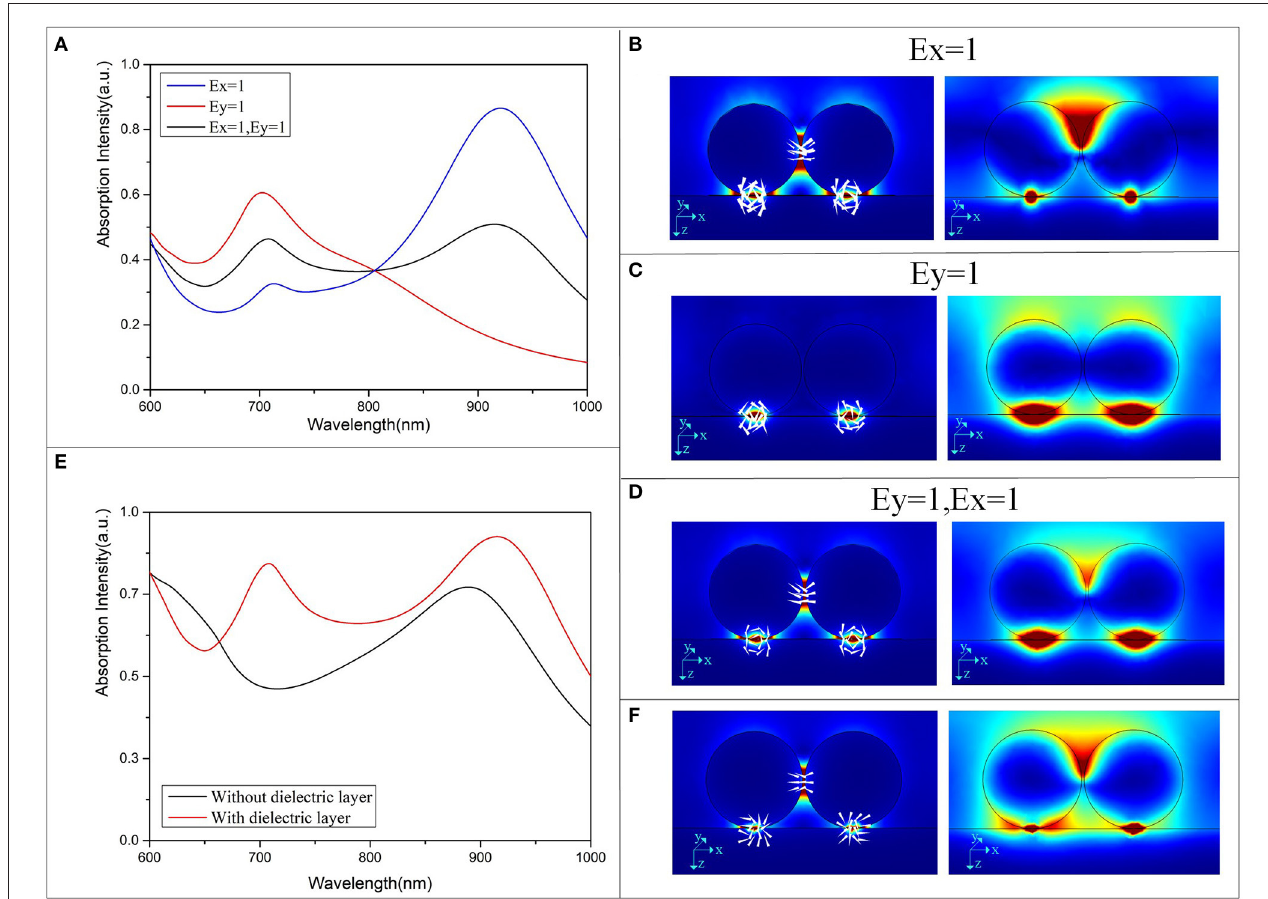
FIGURE 4 | (A) Absorption spectra of Au nanosphere dimer–dielectric–gold film structure with different polarization directions. (B–D) Distribution of the electric field (left) and the magnetic field (right) located at 710nm corresponding to Ex = 1, Ey = 1, and Ex = Ey = 1. (E) The absorption spectra of the structure with and without the dielectric layer. (F) Distribution of the electric field (left) and the magnetic field (right) located at 710nm corresponding to the structure without the dielectric layer.